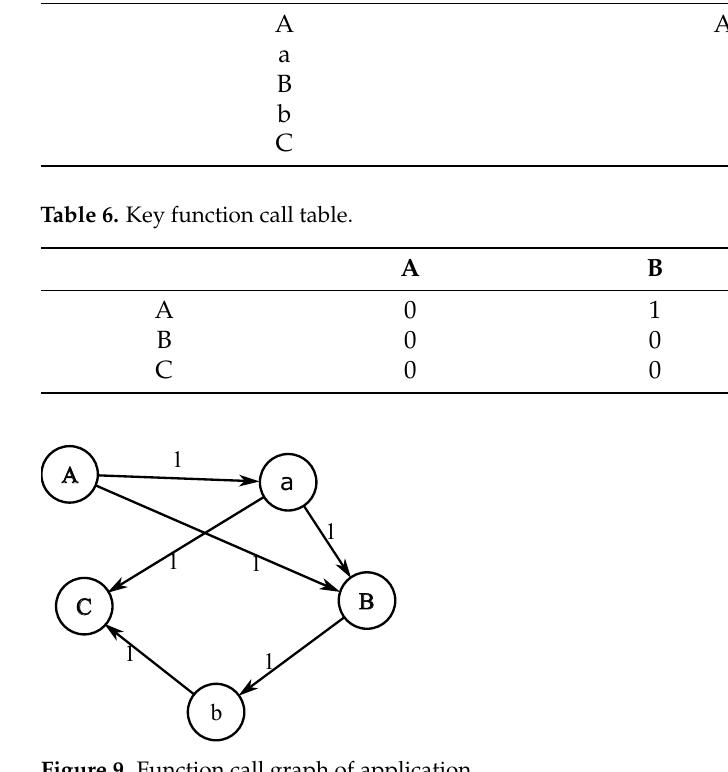
Figure 9. Function call graph of